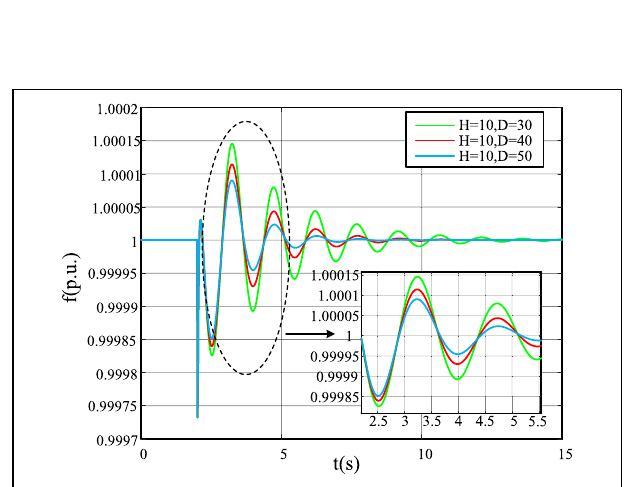
FIGURE 11 | Frequency of the inverter with varying damping coefficients under grid